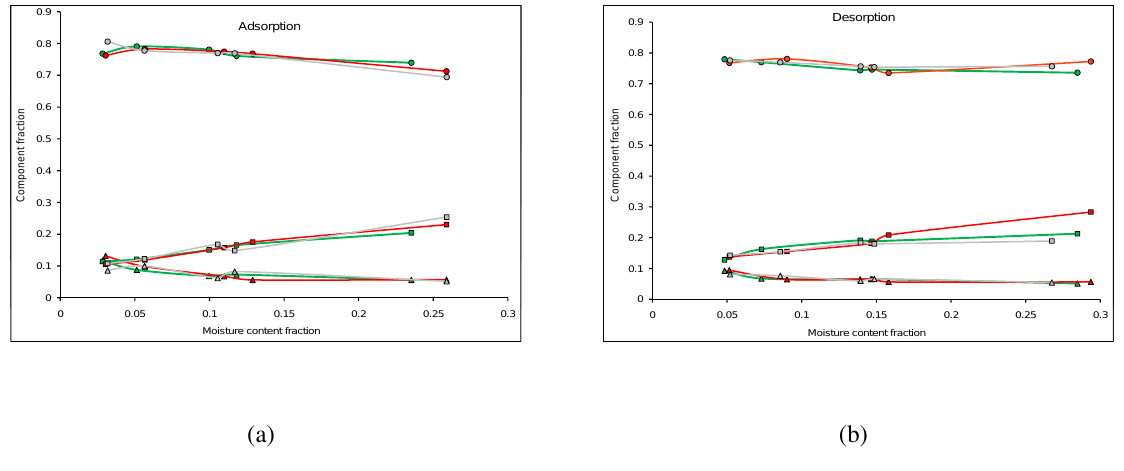
Figure 1. Fractional component analysis for mountain pine beetle affected lodgepole pine conditioned in initial desorption, where the circles correspond to the NMR signal component fitted to the sinc function, the triangles correspond to that fitted to the gaussian function, and the squares correspond to that fitted to the exponential function. The colours correspond to the stage of attack; unaffected (green), red stage (red), and grey stage (grey). The standard error in the points was negligible compared to the size of the symbols used to represent the